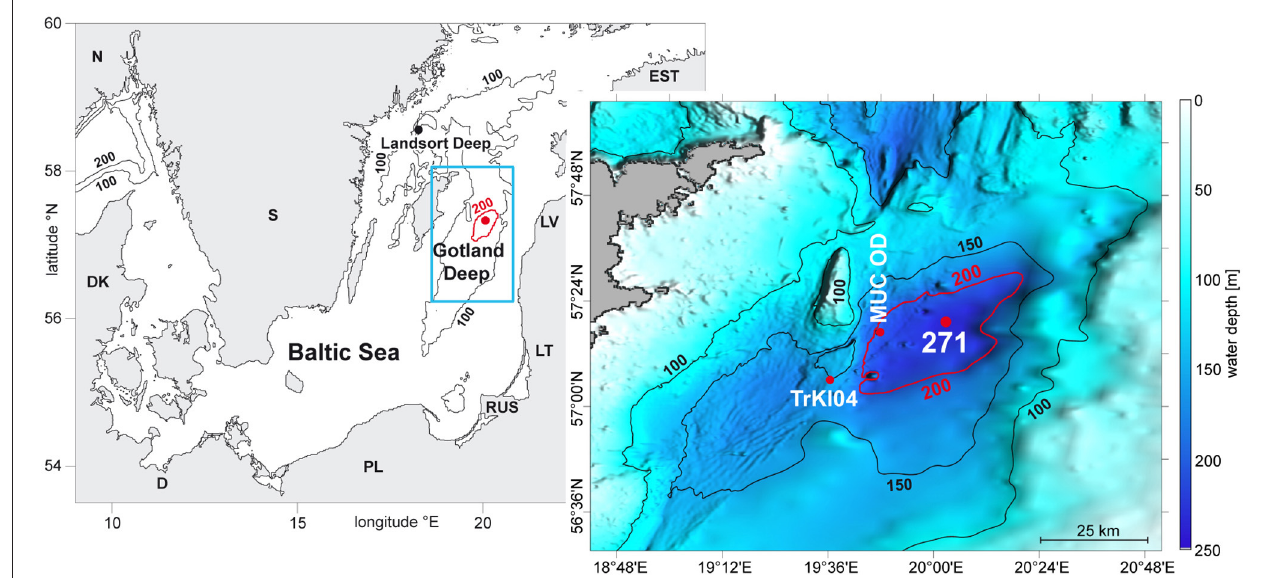
FIGURE 1 | Maps showing main sampling station 271 as well as the surface sediment stations MUC OD and TrKl04 in the central Gotland Basin. The bathymetry is described by the EMODnet Bathymetry Consortium (2016).